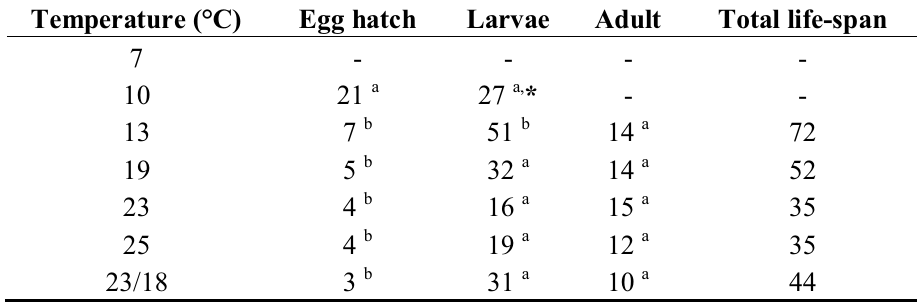
Table 2. Time-span in days of Tuta absoluta life-stages developing at the various temperatures tested (no food supplied for adult moths). Different letters within columns denotes significant differences ( p < 0.05).